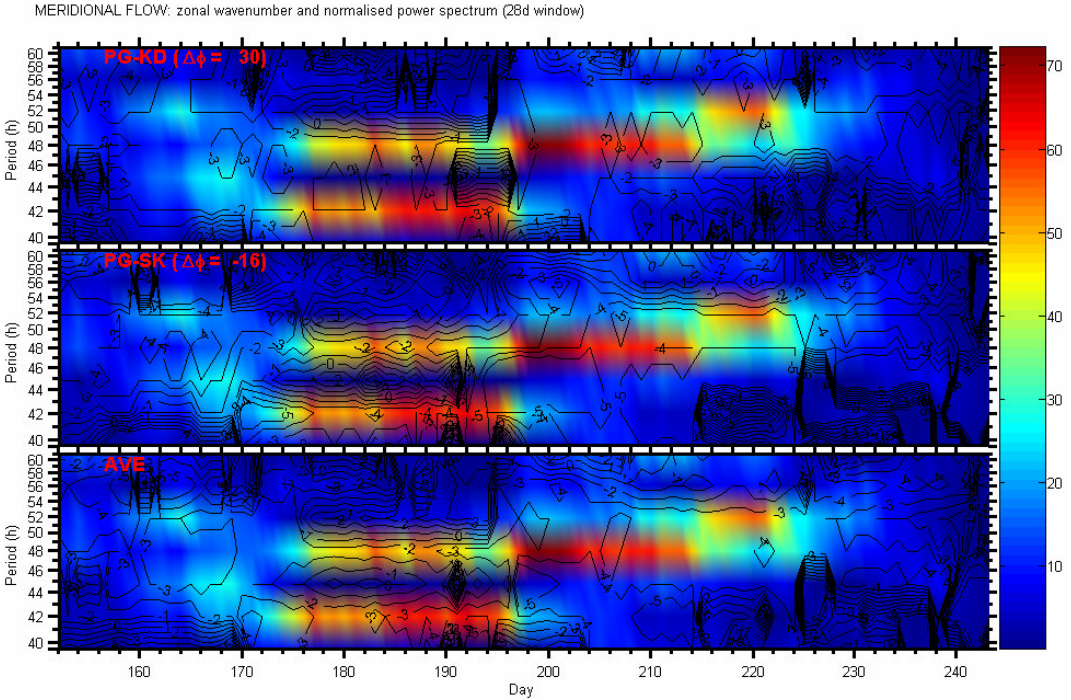
Fig. 9. (a) The zonal wave number spectrum overlaid on the cross-spectral amplitude of the wave (colour) for PG-KD cross-spectral analysis. (b) Same as (a) but for PG-SK analysis. (c) Average of (a) and (b). (Same as the previous version) φ ∆ represents the longitudinal separation between the sites.